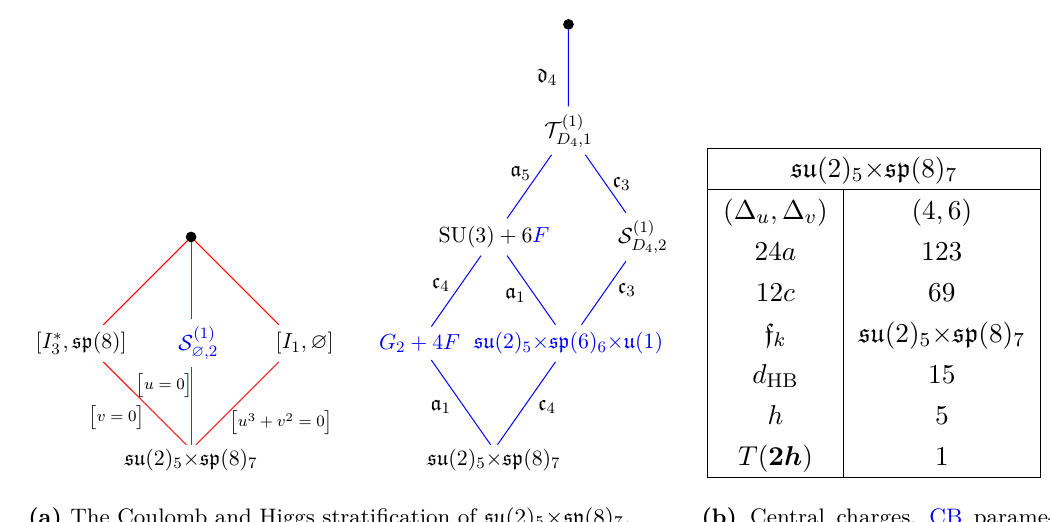
Figure 30. Information about the su (2) 5 × sp (8) 7